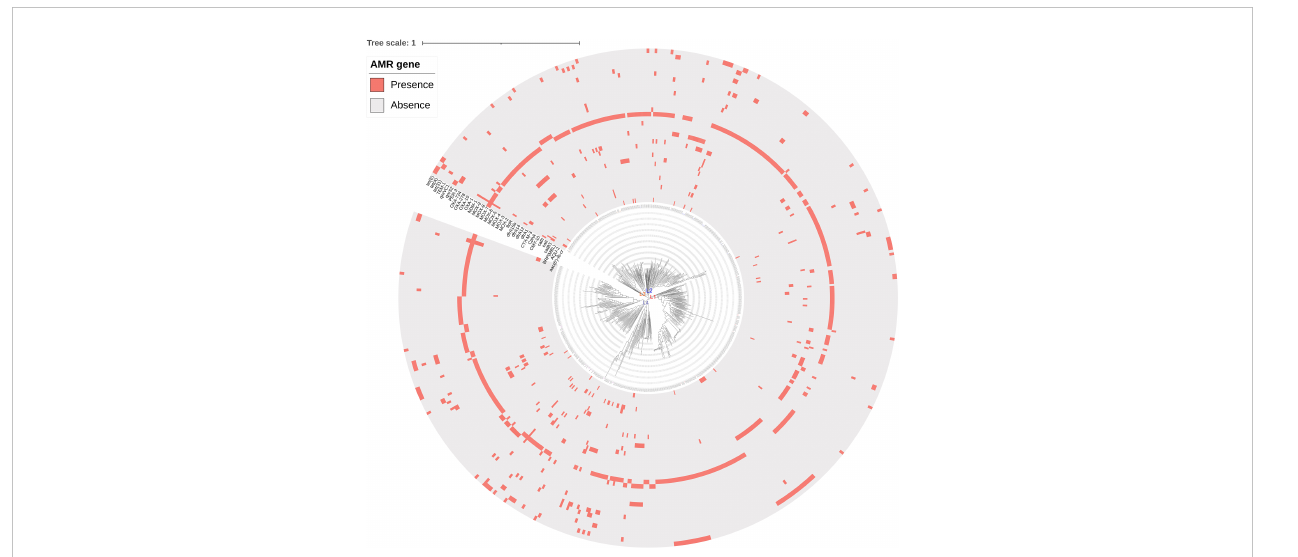
FIGURE 2 Phylogenetic tree of 568 A. caviae strains. Maximum likelihood phylogenetic tree was constructed using RAxML (v8.2.4). The 47 isolates in L1, L2, L3, and L4 clusters were marked in red, blue, orange, and purple color, respectively. AMR gene: antimicrobial resistance gene.